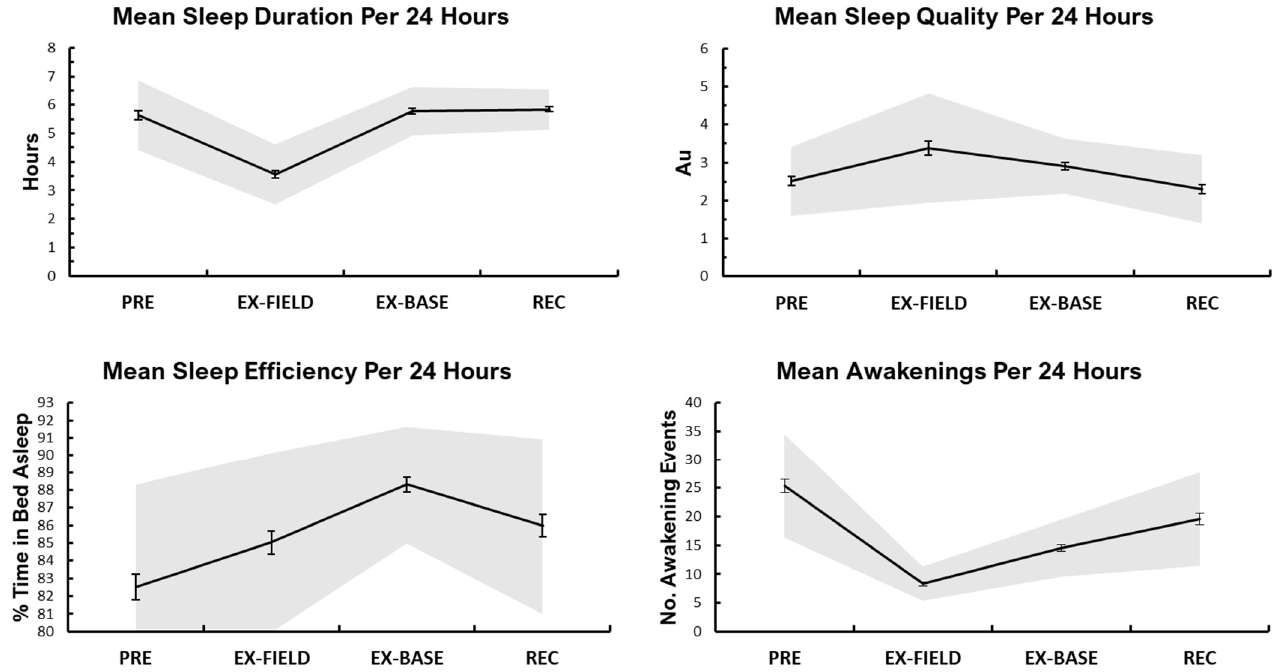
Figure 4. Means per study phase ( ± SE) for sleep metrics. NOTE: Au, arbitrary units. All variables significantly affected by time across the four study phases p < 0.05.